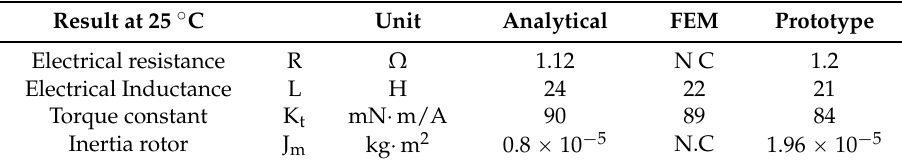
Table 3. Performance comparison.